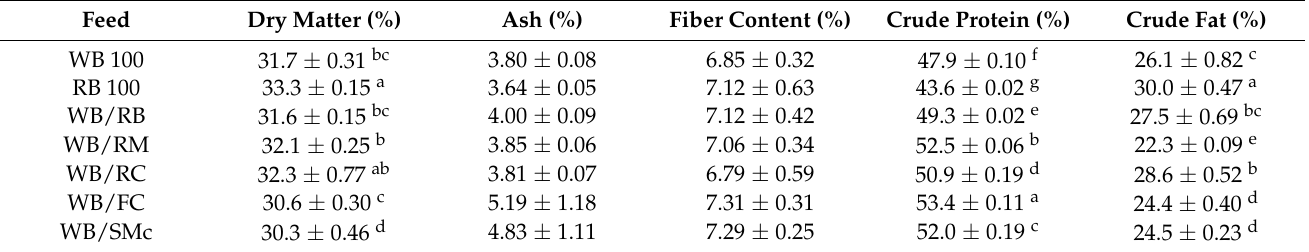
Table 4. Proximal composition (% on dry weight basis) of 11-week-old mealworm larvae grown on experimental